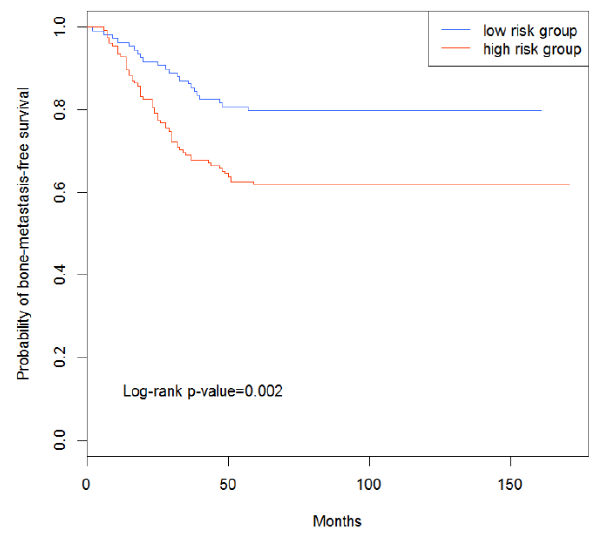
Figure 2. Survival analysis of the independent data set.